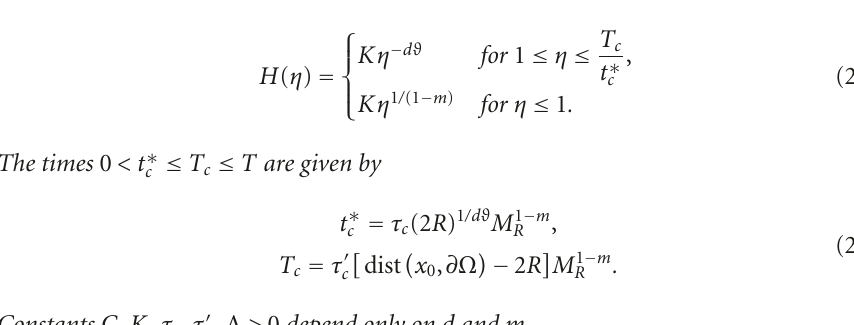
Figure 2.2. Approximative graphic of the functions u ( t , x ) (dotted line) and H ( t ) (solid line). (cid:19) u x ) dx . Function H ( t ) is positive and takes the precise where M R = M R /R d , M R = B R 0 (